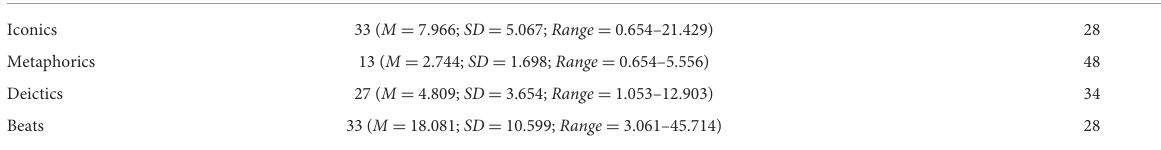
TABLE 4 Number of gesturers and non-gesturers of four types of gestures. Number of gesturers ( Mean , SD , and Range of gesturers’ gesture rate)